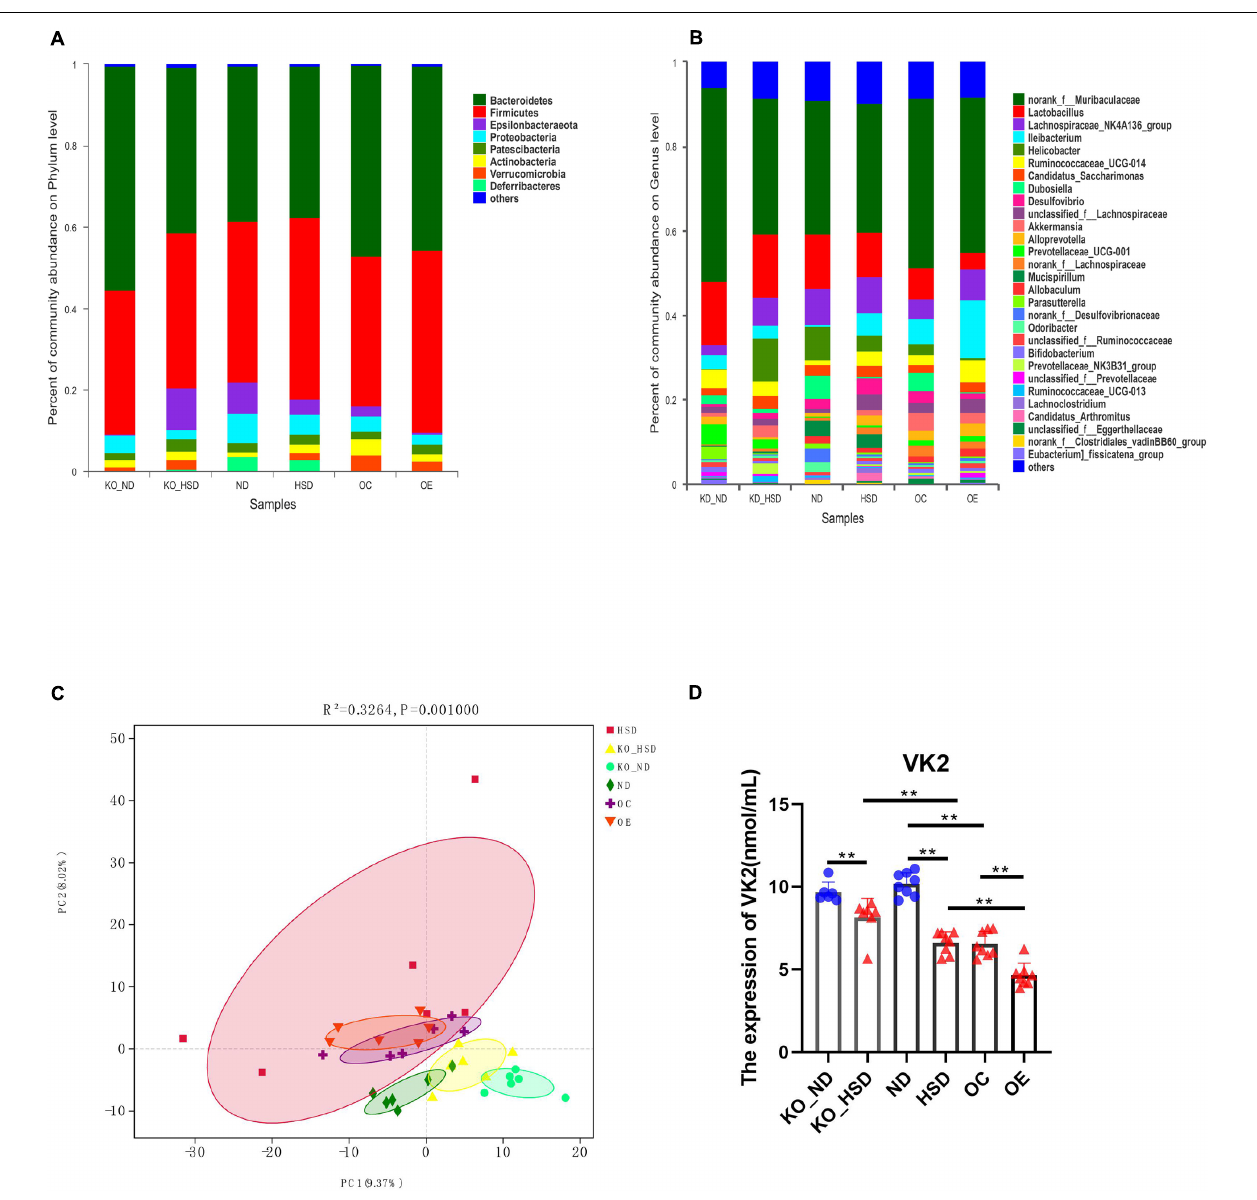
FIGURE 3 | ATF4 altered the composition of gut microbiota and expression levels of the microbial metabolite VK2 in high-salt-induced hypertensive mice. (A) Relative abundance plots displaying the differences in the microbial community structure at the phylum level. (B) Relative abundance plots displaying the differences in the general microbial community structure. (C) PCA plots were used to visualize differences in weighted UniFrac distances of samples of OTUs from different groups ( R 2 = 0.3264, p = 0.001). (D) ATF4 altered the expression of VK2. Data are presented as mean ± SD; ** p < 0.01, n = 6–8; statistical comparisons were performed using Student t test or one-way analysis of variance (ANOVA). ATF4, activating transcription factor 4; KO, Atf4 ± mice; WT, wild-type mice; SBP, systolic blood pressure; NO, nitric oxide; VEGF, vascular endothelial growth factor; ANGI, angiotensin I; ET-1, endothelin-1; KO-ND, Atf4 ± mice with natural diet; KO-HSD, Atf4 ± mice with high-salt diet; ND, WT mice with natural diet; HSD, WT mice with high-salt diet; OE, Atf4 overexpression with high-salt diet; OC, Atf4 overexpression control with high-salt diet.